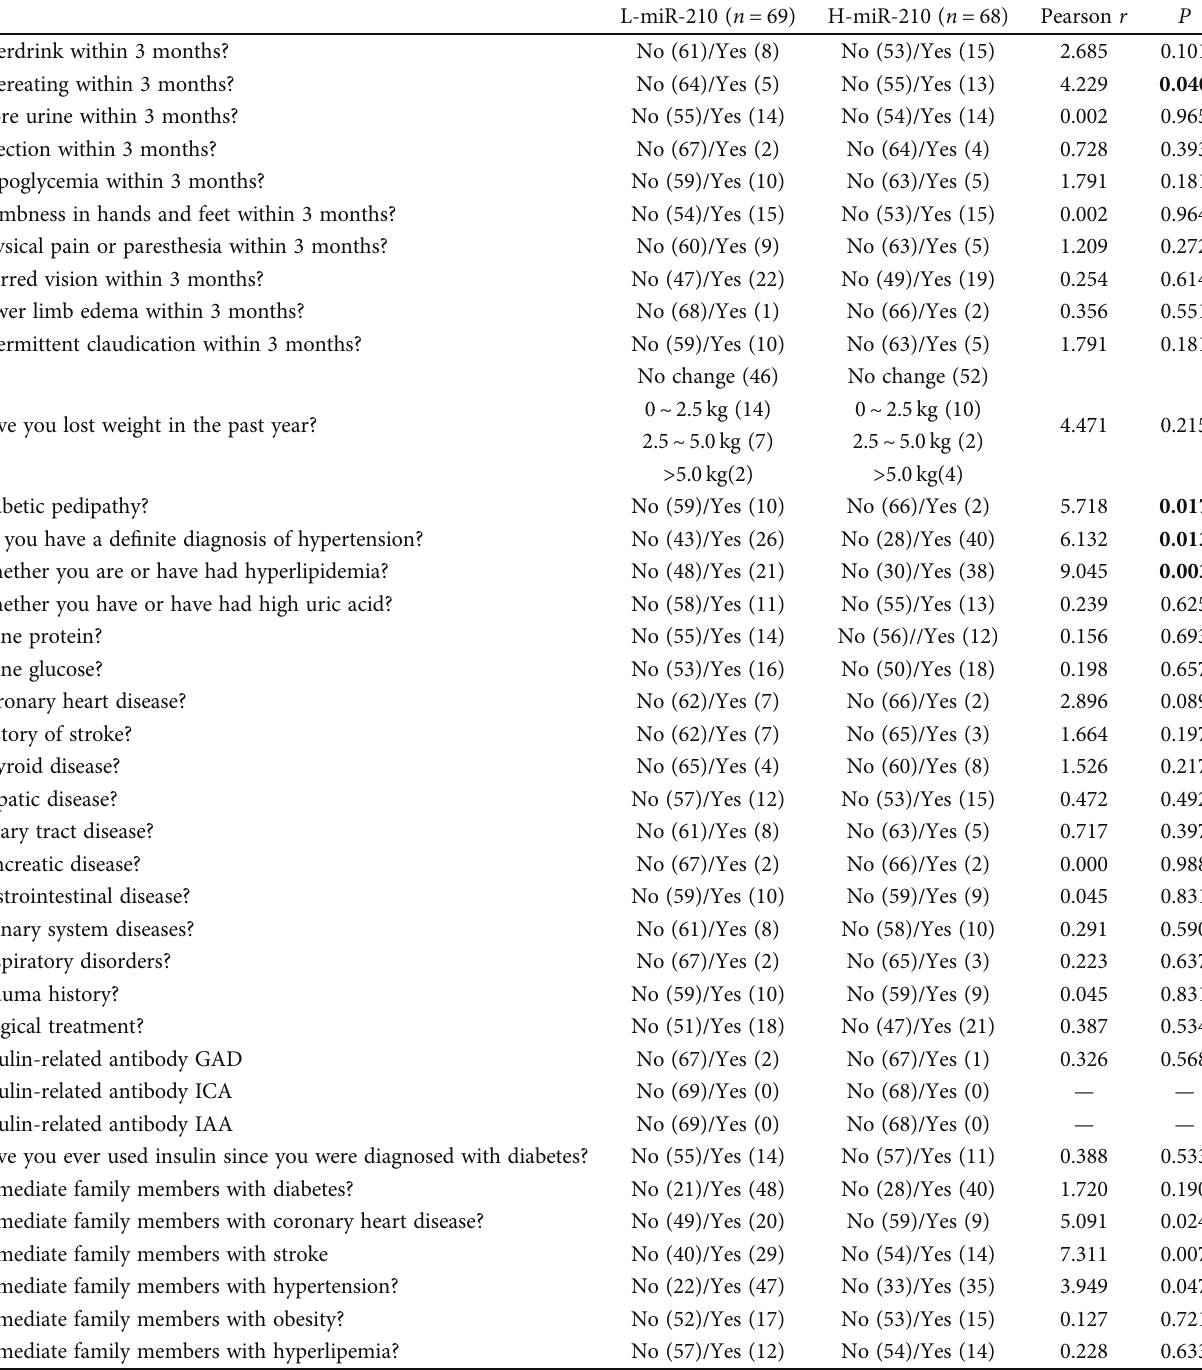
Table 4: The correlation of disease history with high and low miR-210 level groups in patients with type 2 diabetes